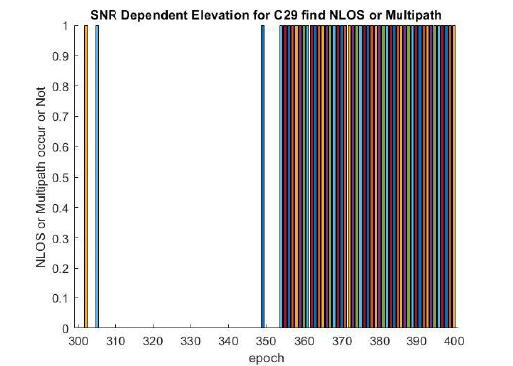
Figure 16. SNR Dependent Elevation find NLOS or Multipath for C29 ( In this figure, if multipath or NLOS detected bar shows 1, and if not shows 0. Also in this figure colors do not have special meaning. )